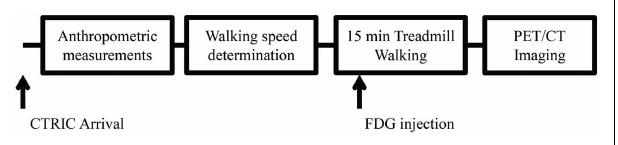
FIGURE 1 | Representative image of the experimental timeline .